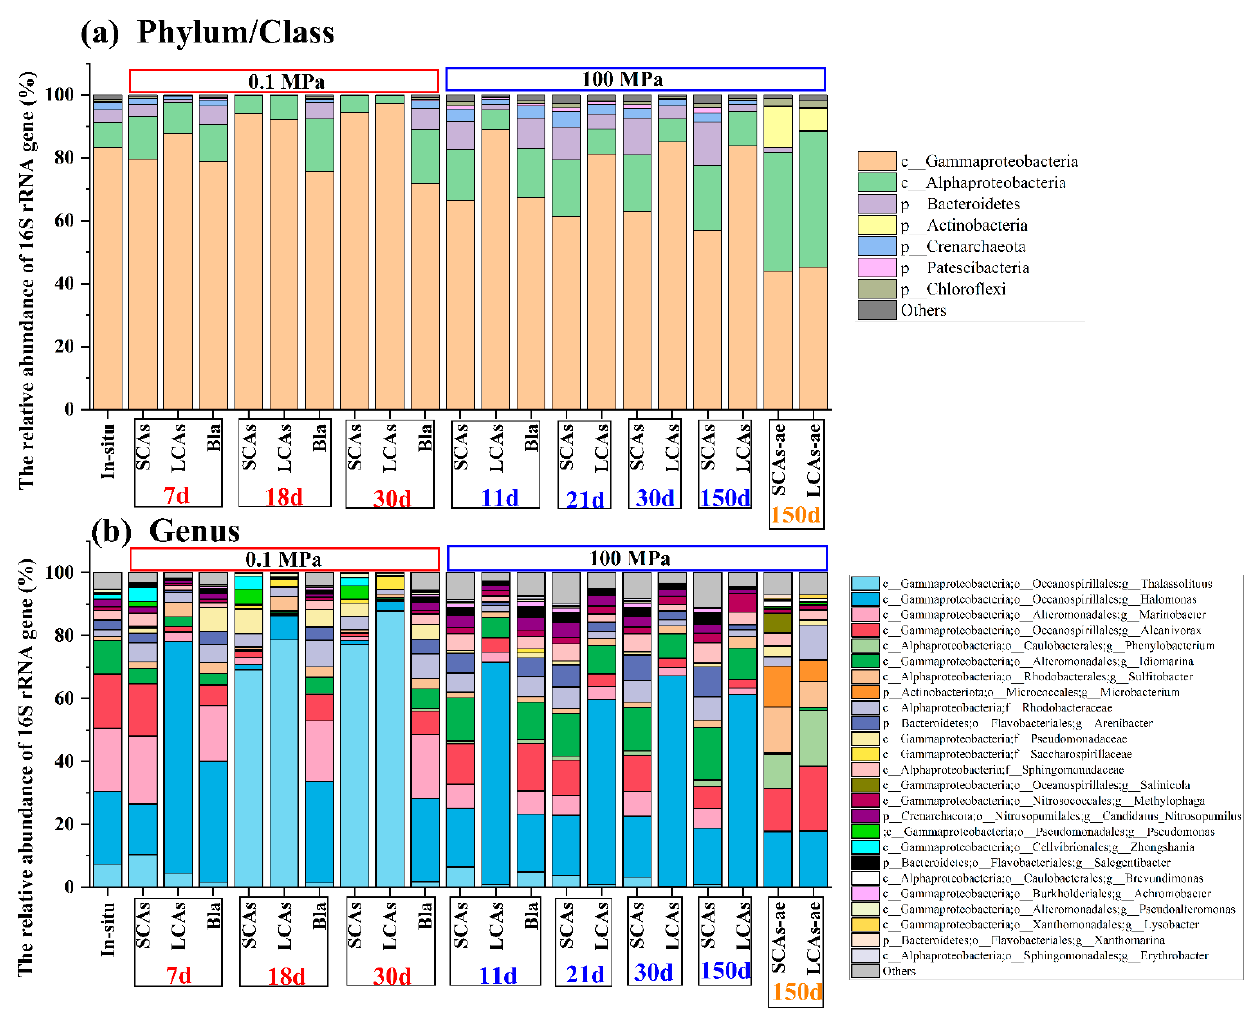
Figure 2. The most abundant microbial communities in the aerobic and anaerobic hydrocarbon enrichments under 0.1 and 100 MPa conditions at phylum ( a ) and genus ( b ) levels, respectively. Note: SCAs, short-chain alkanes; LCAs, long-chain alkanes; SCAs-ae: MT sediments with short-chain alkanes incubated aerobically; LCAs-ae: MT sediments with long-chain alkanes incubated aerobically; Bla, Blank.